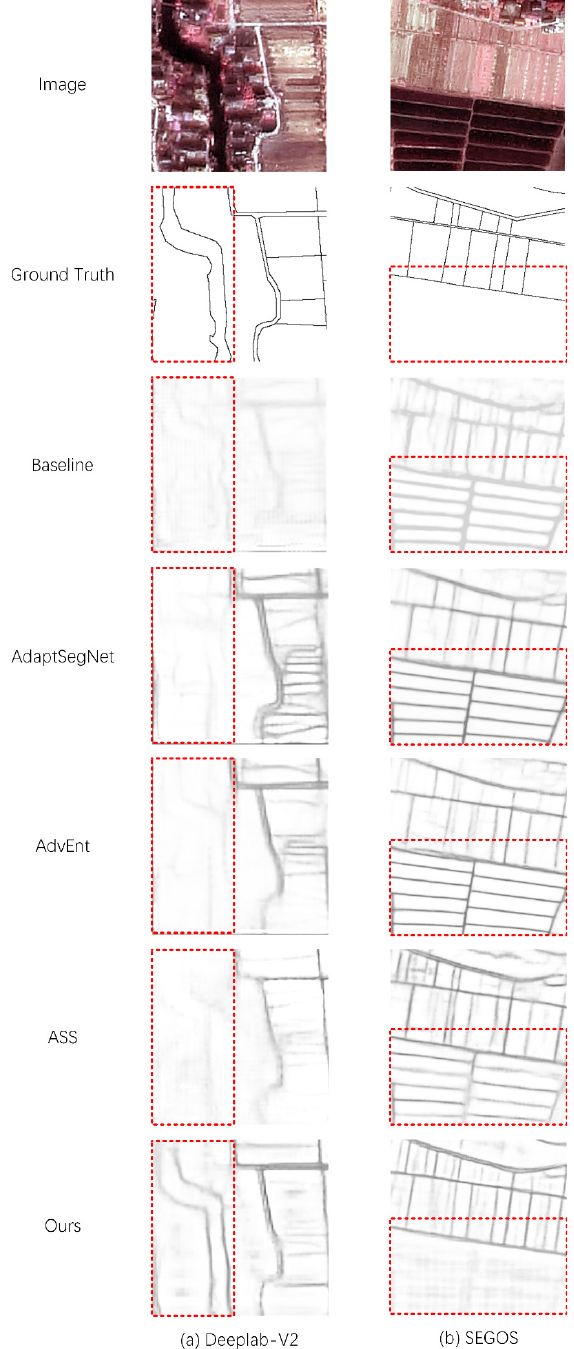
Figure 4. Comparison of the results of domain adaptation methods. ( a , b ) are the results of different edge extraction networks on the image. For each image, we show the results of baseline, AdaptSegNet, AdvEnt, ASS, and our method.